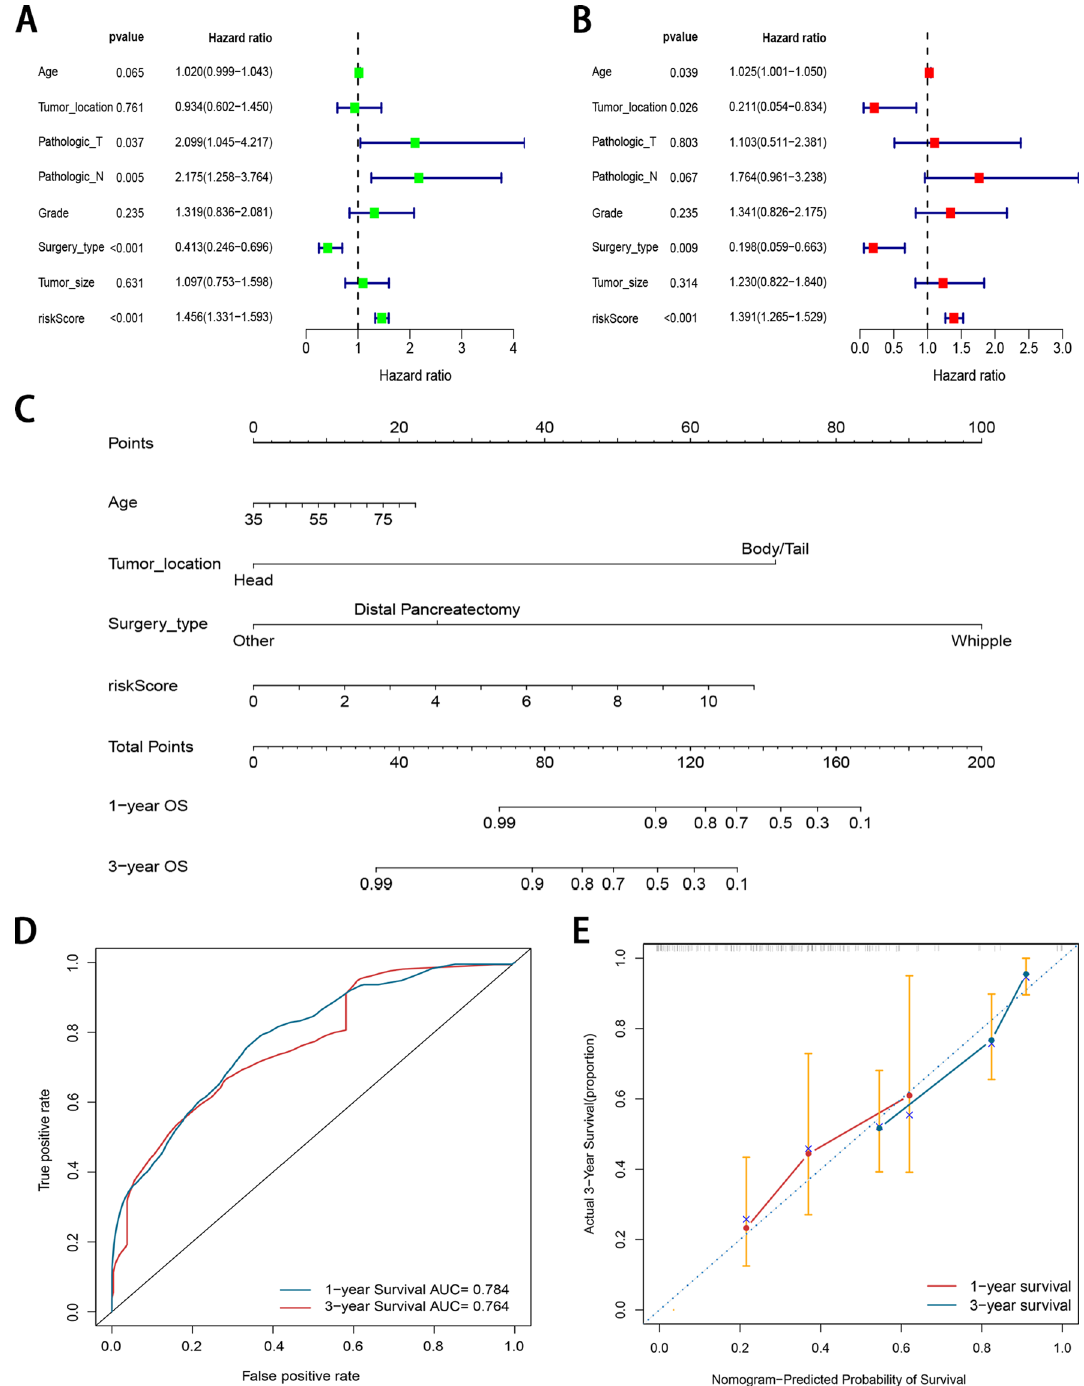
Figure 6. Development of a nomogram for survival prediction of PDAC patients based on signature and clinical characteristics. ( A , B ) Univariate and multivariate Cox analyses simultaneously demonstrated the independent prognostic value of the risk score. ( C ) The nomogram combining risk signature and clinicopathological factors. ( D ) AUCs on the nomogram suggested that this model had higher accuracy in OS at 1 and 3 years. ( E ) Calibration plots were established to compare the proposed nomogram with an ideal